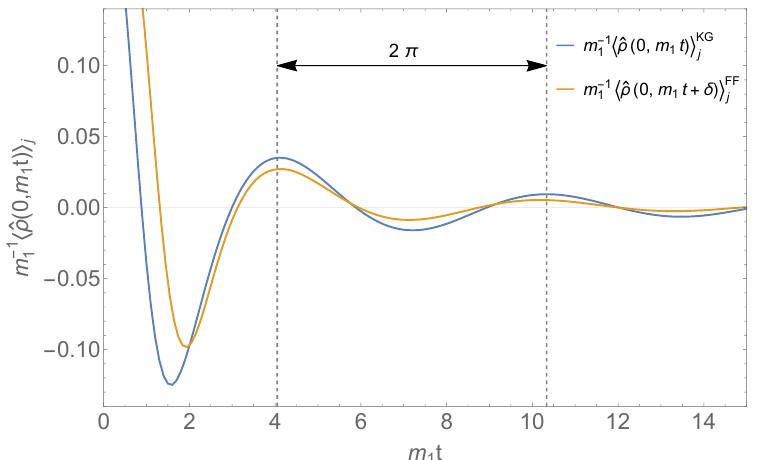
Figure 4.11: Klein–Gordon (blue line) and free fermion (orange line) time evolved 〈 ˆ ρ ( 0, t ) 〉 expectation values of m − 1 at the fixed position x = 0 for an external field j 1 / m = 5 and bump-width m σ = 2 / 3. For the computation of with amplitude A β FF 1 1 the free fermion dynamics a numerically exact method was used and for the Klein– (cid:112) 〈 ˆ ρ ( x , t ) 〉 〈 ∂ π ˆ ϕ ( x , t ) 〉 Gordon case m − 1 was obtained by rescaling m − 1 with 1 / j x j 1 1 which corresponds to the β = β point. For better transparency, the time argument FF 〈 ˆ ρ ( 0, t ) 〉 FF in free fermion quantity m − 1 was shifted by δ = 0.45. Note that the initial j 1 / 〈 ˆ ρ ( 0,0 ) 〉 KG = ratio 〈 ˆ ρ ( 0,0 ) 〉 FF j j